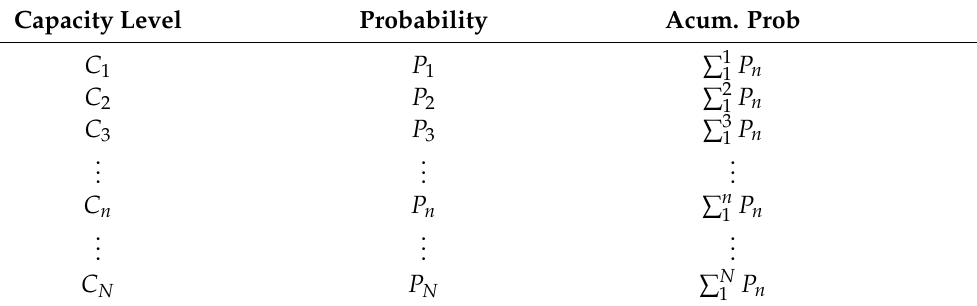
Table 1. Generic Capacity Outage Probability Table